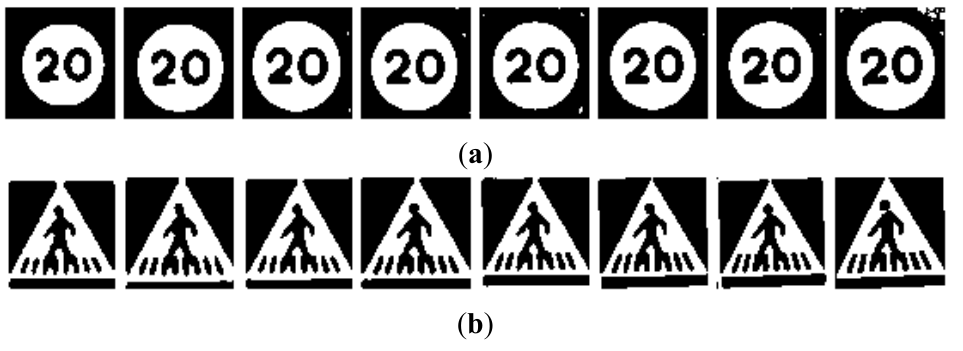
G4 : the fourth set of candidates, depicted in Figure 8, is done using an Otsu thresholding. Figure 8. Examples of candidates in Figure 5 processed using Otsu thresholding for ( a ) Red road signs. ( b ) Blue road signs.